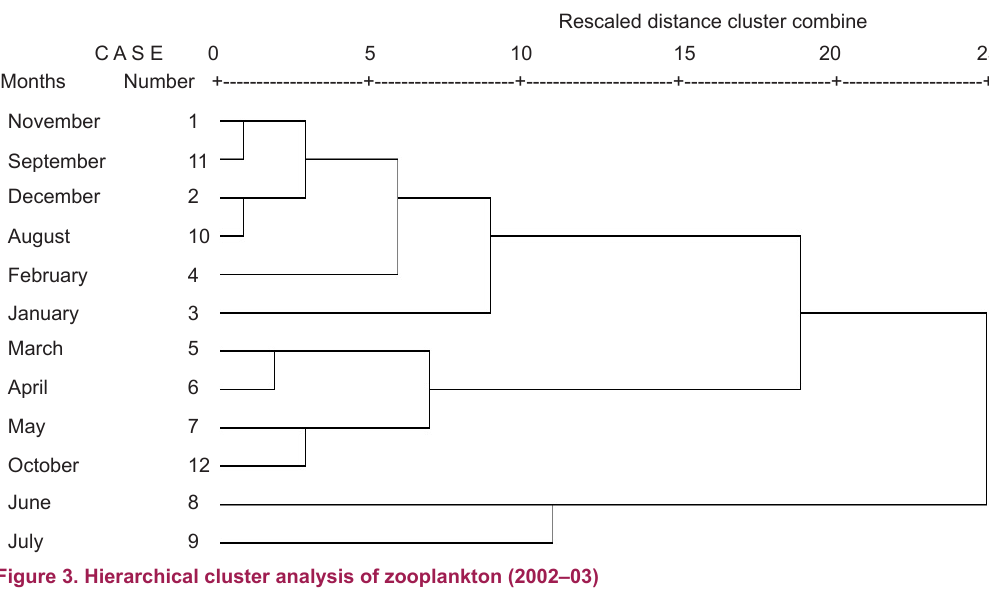
Figure 3. Hierarchical cluster analysis of zooplankton (2002–03)